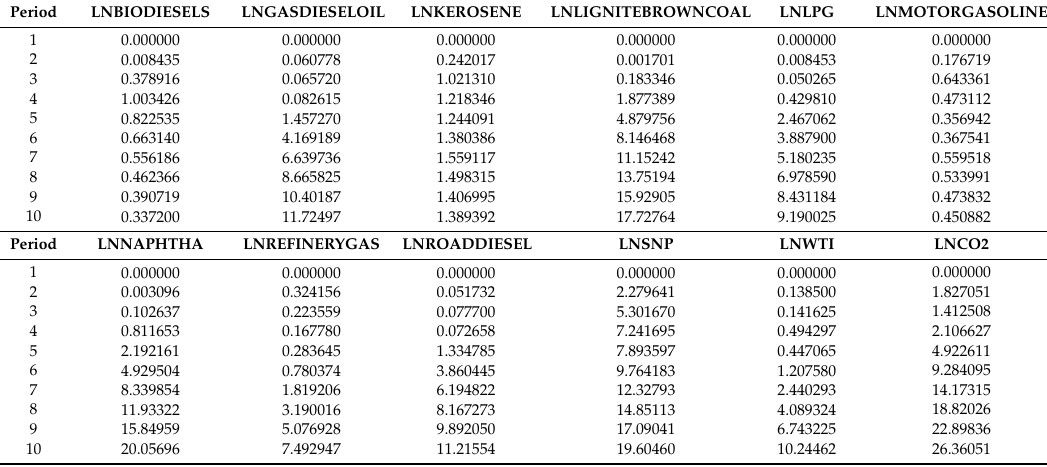
Table 9. Variance